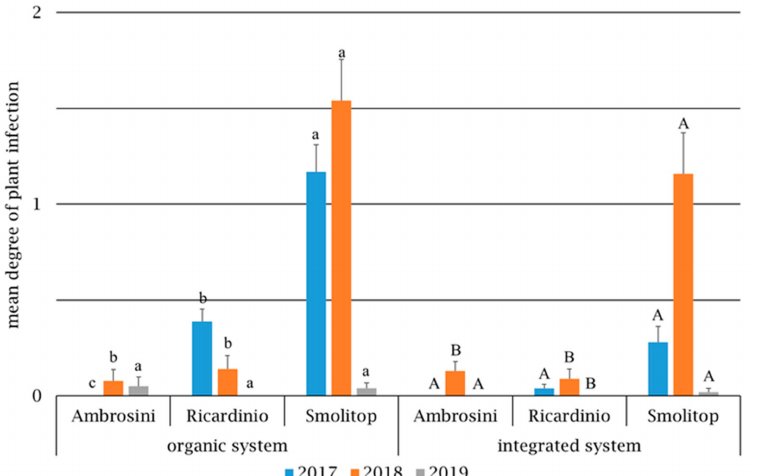
Figure 3. Plant infection (mean ± SEM) with corn rust of three maize varieties in the years 2017–2019 in two cultivation systems; different letters denote significant differences among varieties (Ambrosini, Ricardinio, Smolitop) in the same year for organic (lowercase letters) and integrated (capital letters) farming, according to the Kruskal–Wallis test at p ≤